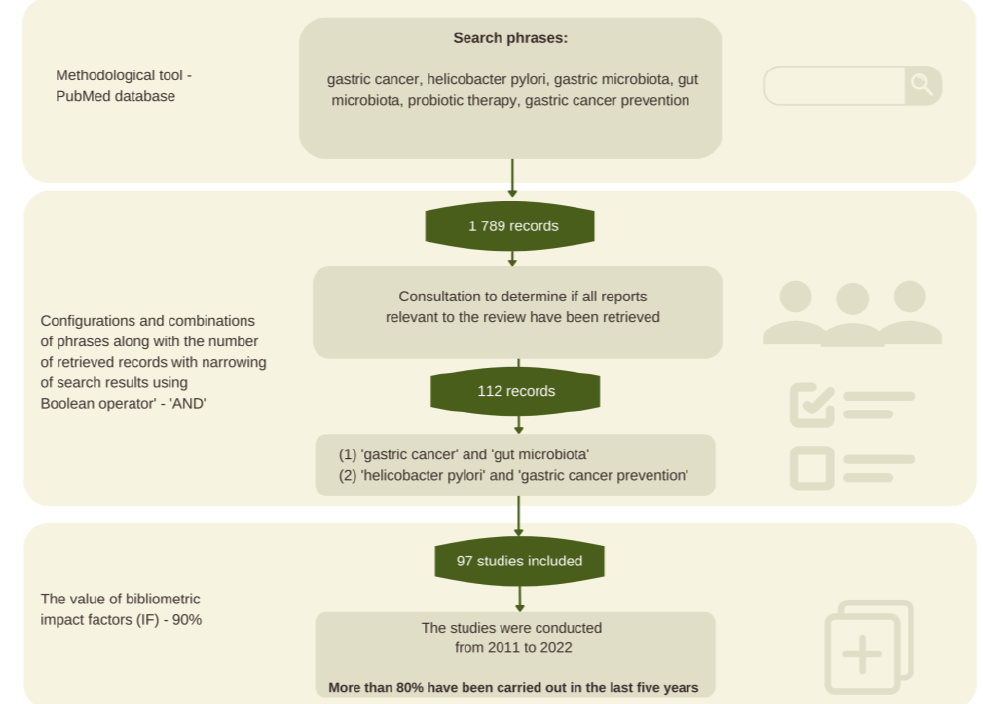
Figure 1. Methodological scheme. Source: own study.